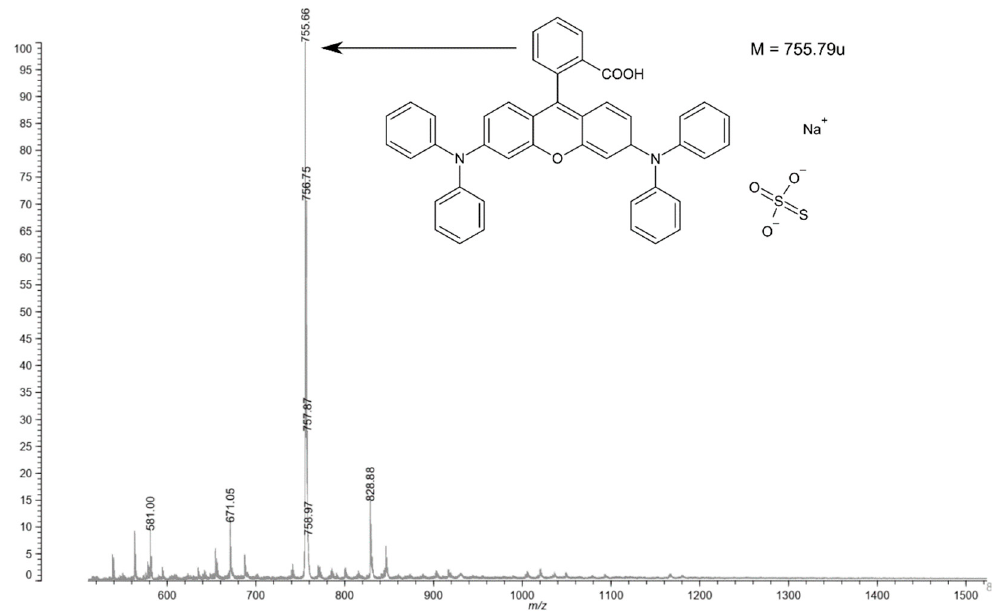
Figure 2. Mass analysis of rhodamine B derivative .